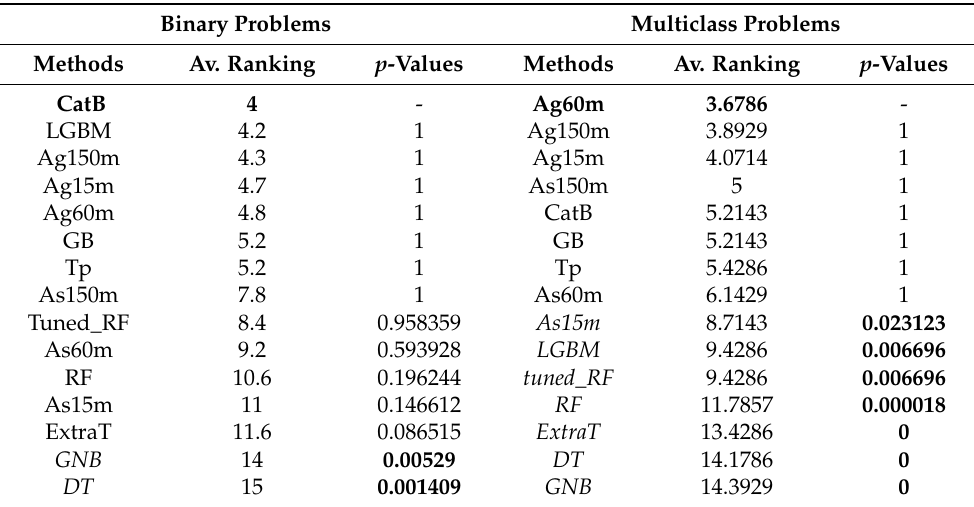
Table 8. Friedman’s average ranking and p -values obtained via the Holm post-hoc test using CatB and Ag60m as control methods in binary and multiclass datasets,